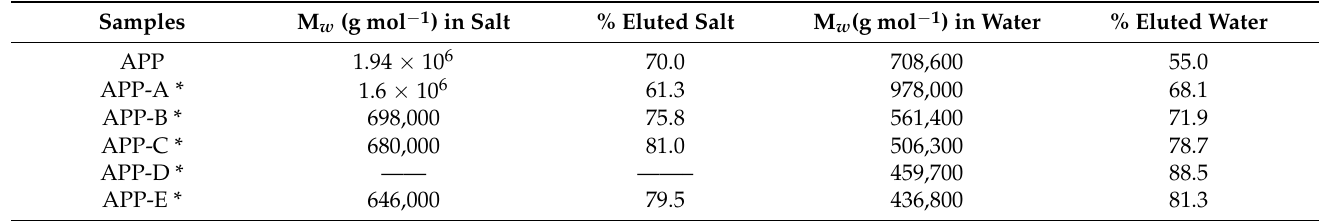
Table 3. SEC characterization of pectins after progressive demethylation dissolved in NaNO 3 and water. M w is taken for all the chromatograms.